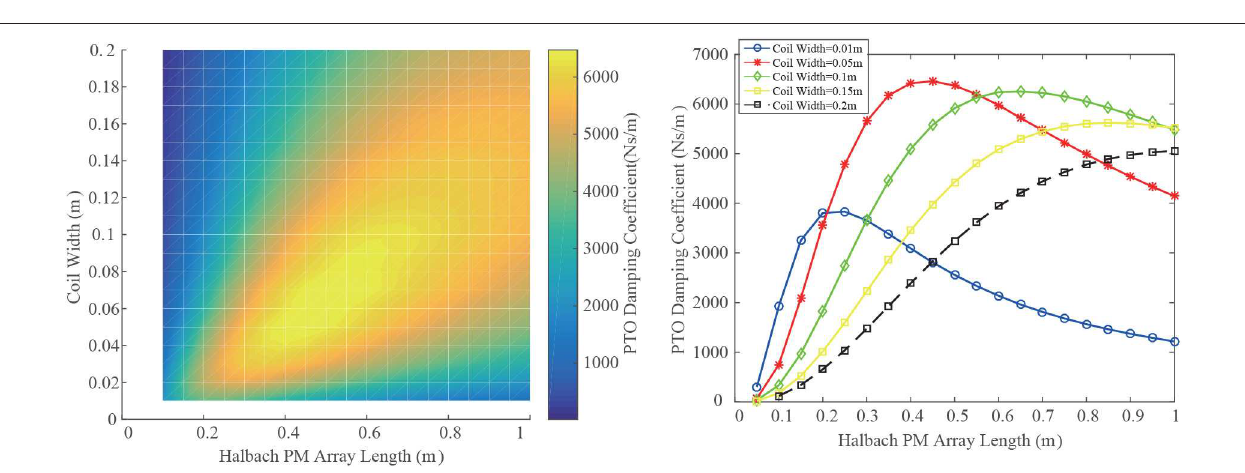
FIGURE 12 | The influence of the Halbach PM array length and the coil